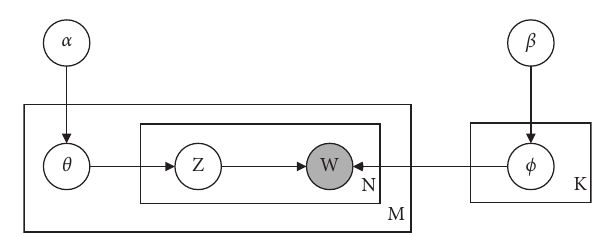
Figure 1: Working mechanisms of